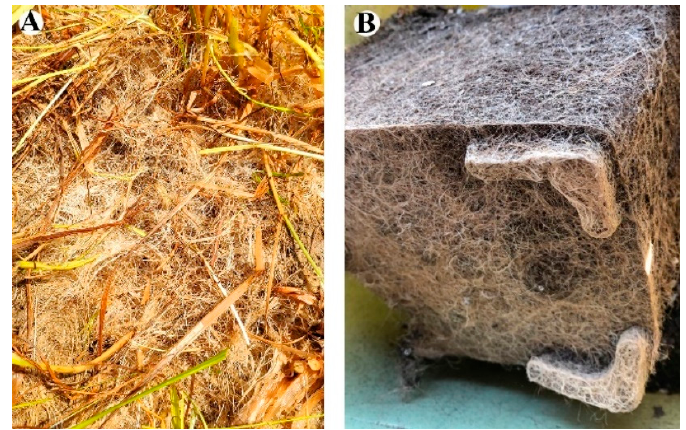
Figure 5. Covering effect of RG aerial root ( A ) and subsurface root ( B ).